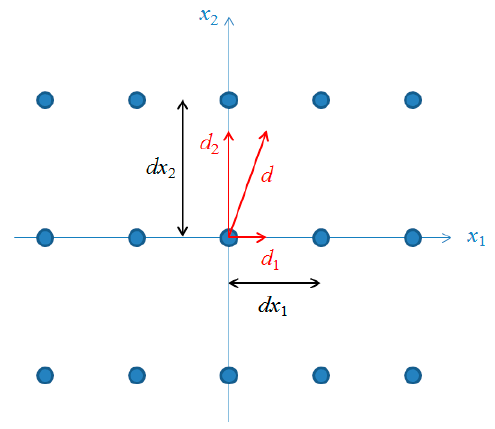
Figure 14. Illustration of modified step size calculation for discrete design variables.